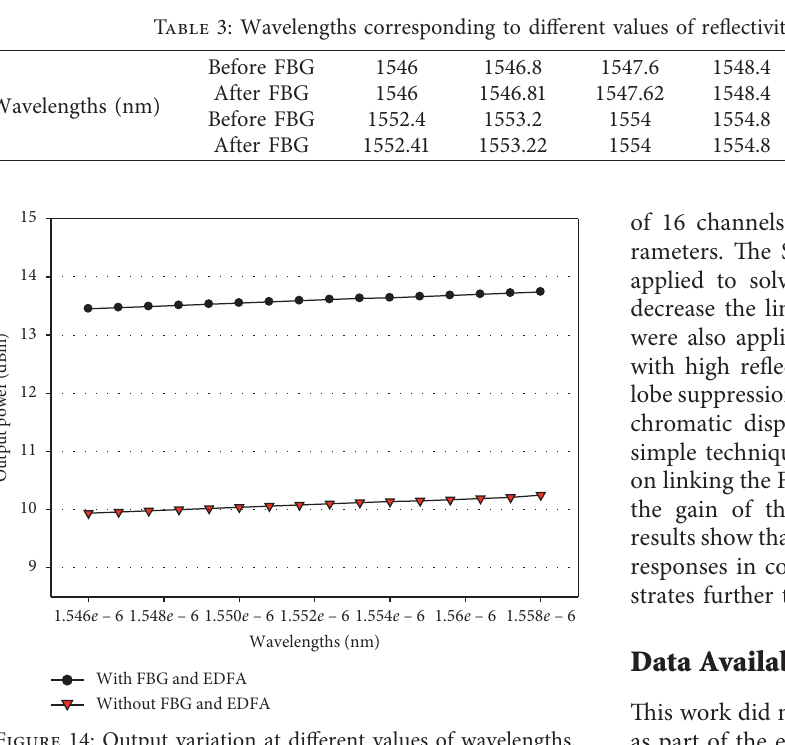
With FBG and EDFA Without FBG and Figure 15: Gain variation at different values of